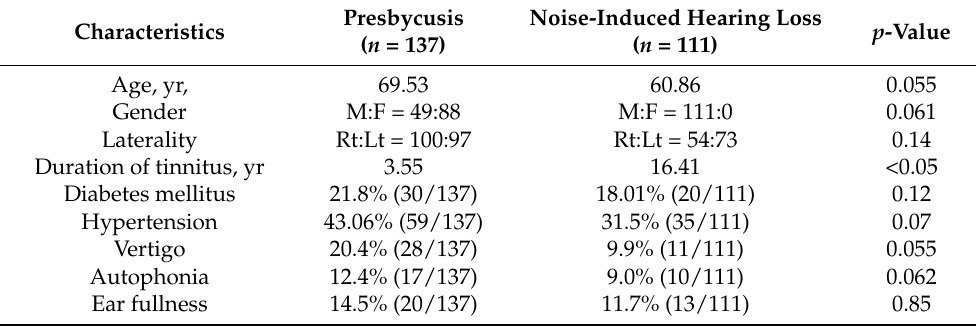
Figure 1. Study flow diagram. Patients with tinnitus were classified into those with SHL and NIHL. Exclusion criteria included insufficient data or a normal hearing threshold. Abbreviations: SHL, presbycusis; NIHL, noise-induced hearing loss. Table 1. Demographic characteristics of patients with noise-induced and presbycusis.